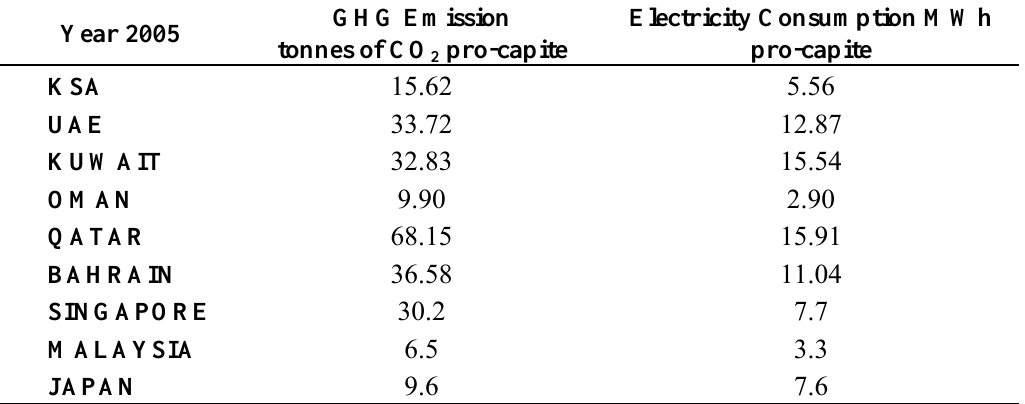
Table 6. GCC countries pro-capite comparison with Malaysia, Singapore and